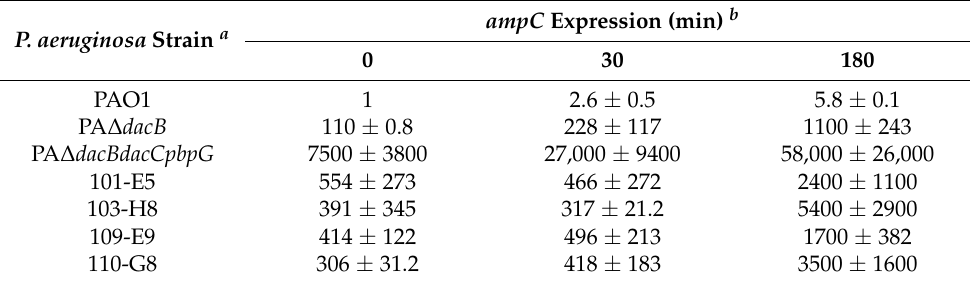
ampC Expression (min)